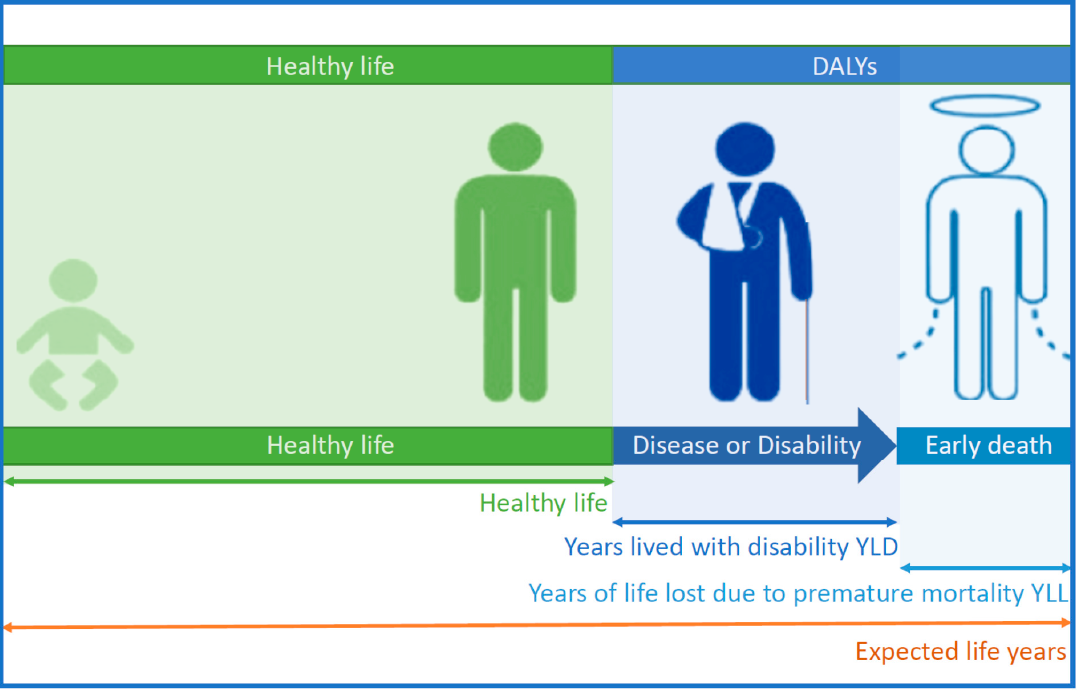
Figure 3. Diagram explaining the meaning of the disability-adjusted life-years (DALY) indicator.